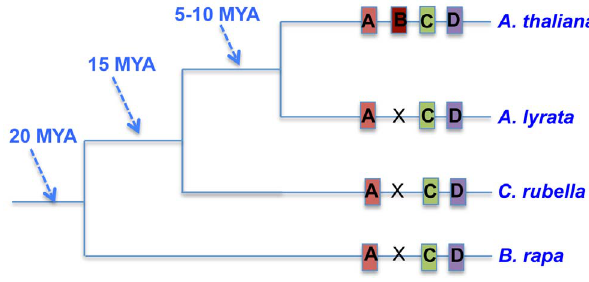
Figure 1. The phylogeny and divergent time among four species. Lineage specific new gene ‘B’ is identified using comparative genomics and syntenic relationship among four genomes.